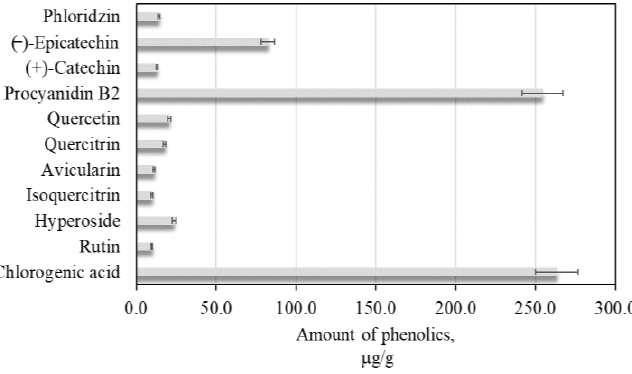
Figure 1. Content of phenolic compounds of apple